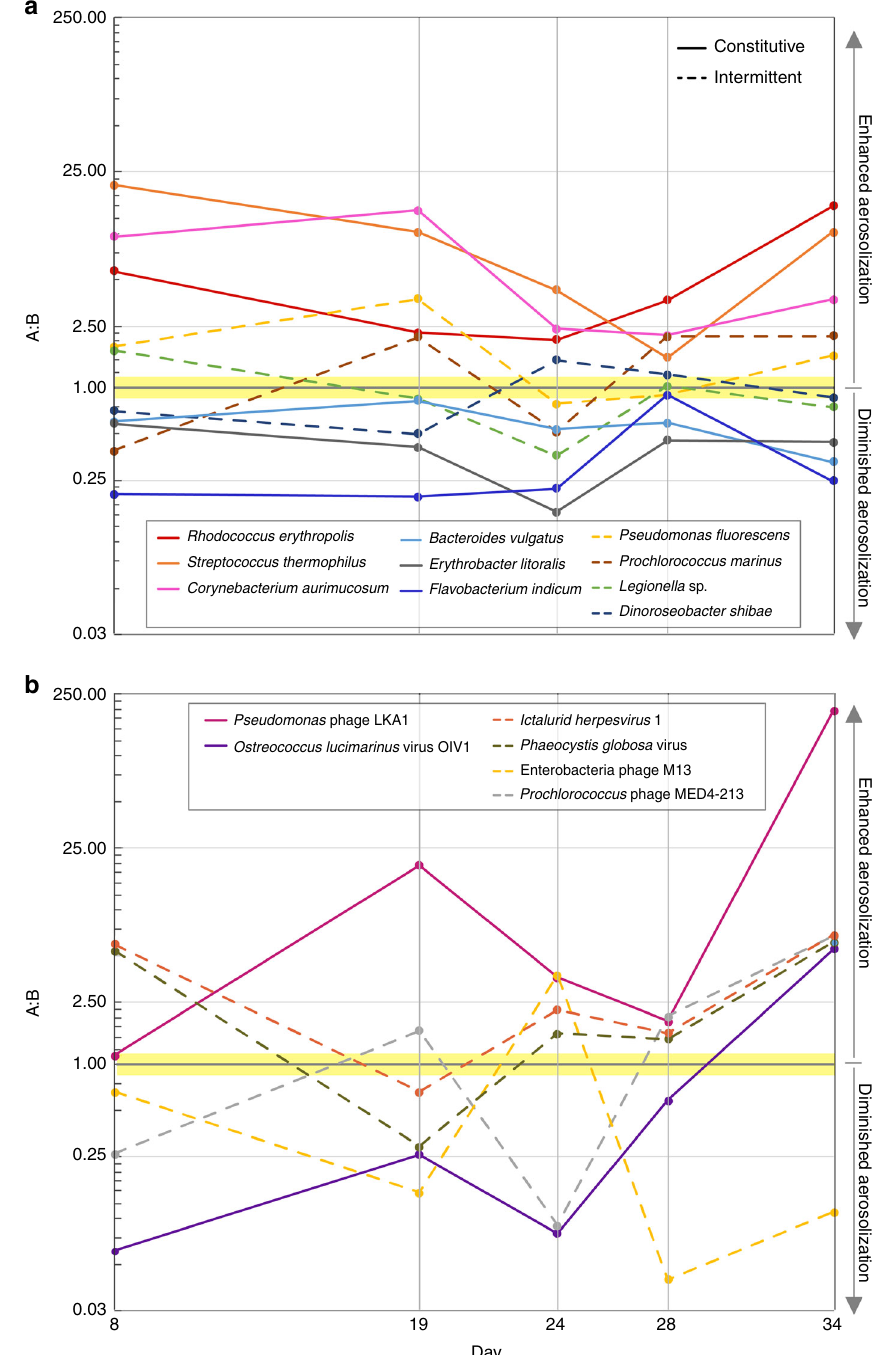
Fig. 4 Temporal aerosolization dynamics. Intermittent versus constitutive aerosolization patterns are shown for select bacteria (10 genomes) a , and viruses (6 genomes) b , across the phytoplankton blooms. Solid lines indicate genomes that are always enriched or always diminished (constitutive). Dashed lines indicate intermittent genomes that demonstrate both